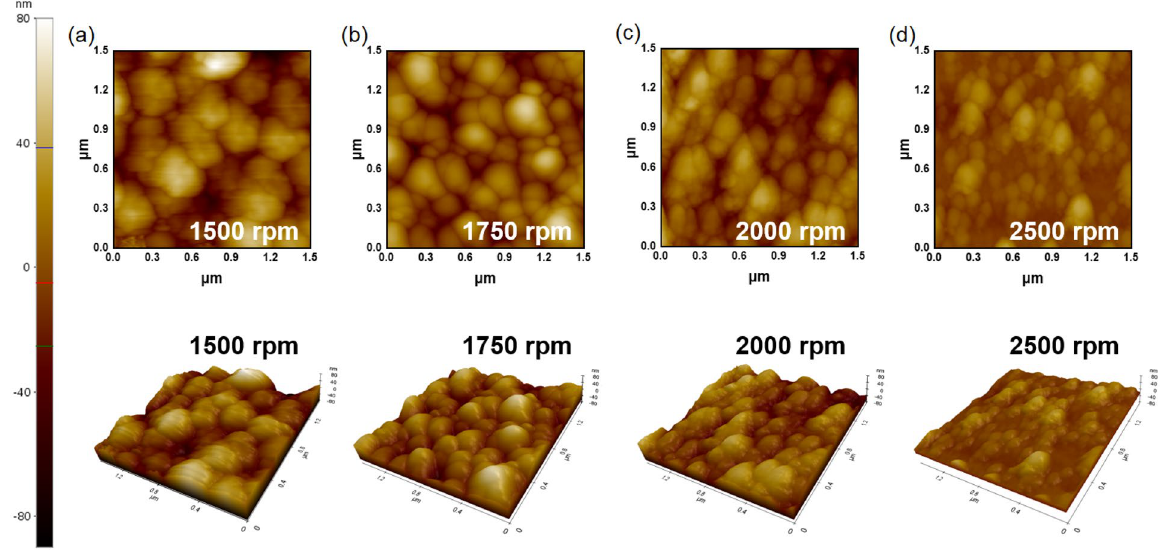
Figure 3. AFM image of ZnO according to PMMA spin coating speed ( a ) 1500, ( b ) 1750, ( c ) 2000, and ( d ) 2500